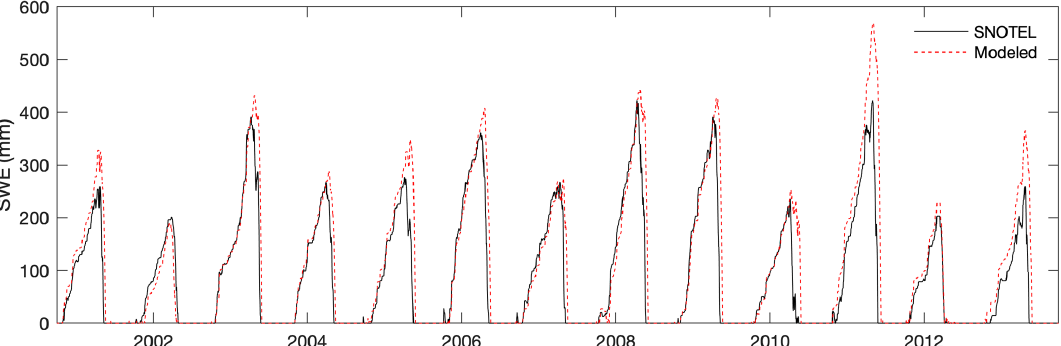
Figure 3. Time series of observed and modeled SWE at the Summit Ranch, Colorado, SNOTEL site. Out of all 170 SNOTEL sites, errors at this site were closest to the all-station median errors reported in the